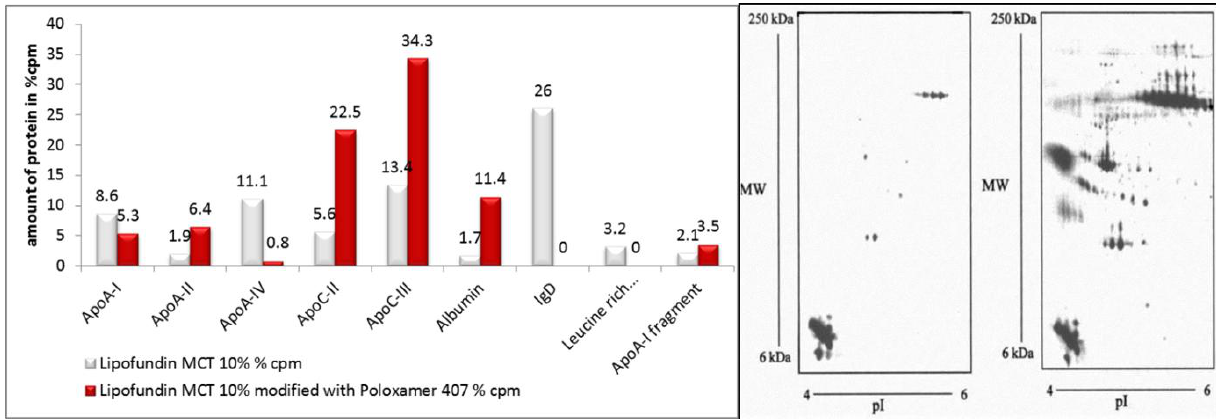
Figure 5. Modification of the adsorption pattern by incubation. Left: Total amount of proteins (cpm) and number of protein spots on Lipofundin MCT 10% emulsions, non-modified and surface-modified with poloxamer 407, and after artificial contamination of the protein solution with emulsion. Right: Close-ups from non-modified Lipofundin MCT 10% emulsion (left) and from Lipofundin MCT 10% emulsion modified with poloxamer 407 (right). The close-ups cover an isoelectric point from 4 to 6 and a molecular mass of 6–250 kDa (non-linear). The first dimension was carried out using IPG strips (after